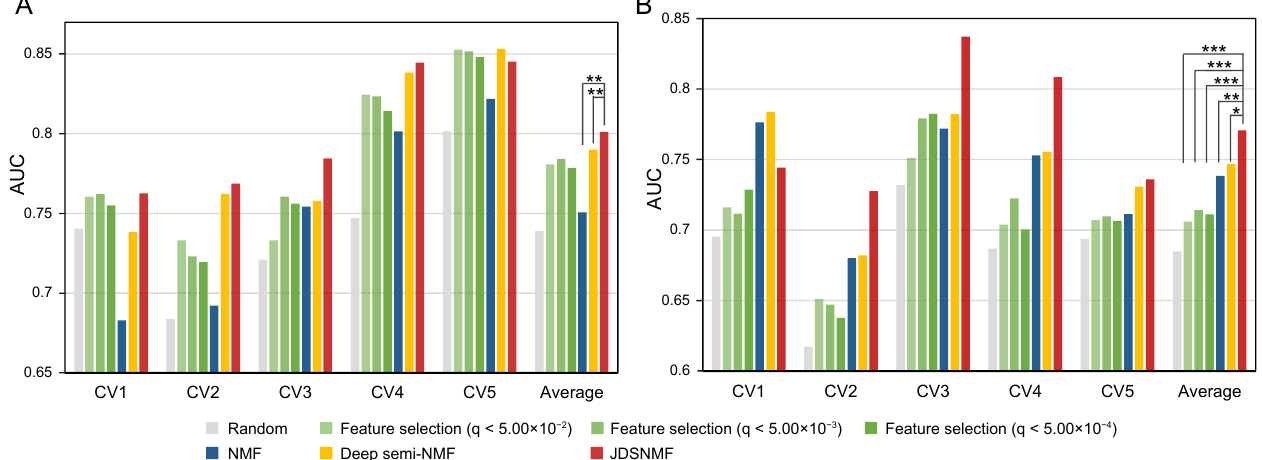
Figure 4. Comparison of the feature selection methods, NMF, deep semi-NMF, and JDSNMF, using the Addneuromed cohort. ( A ) AD/NL classification. ( B ) MCI/NL classification. Three classifiers (deep neural network, support vector machine, and random forest) were used as classifiers, and area under the curve (AUC) values between true positives and false positive rates were measured for classification performance. Then, the average AUC values of the three classifiers are shown for each CV fold. Stars indicate statistical significance with a Wilcoxon signed-rank test (*, p -value < 0.1; **, p -value < 0.05; ***, p -value <